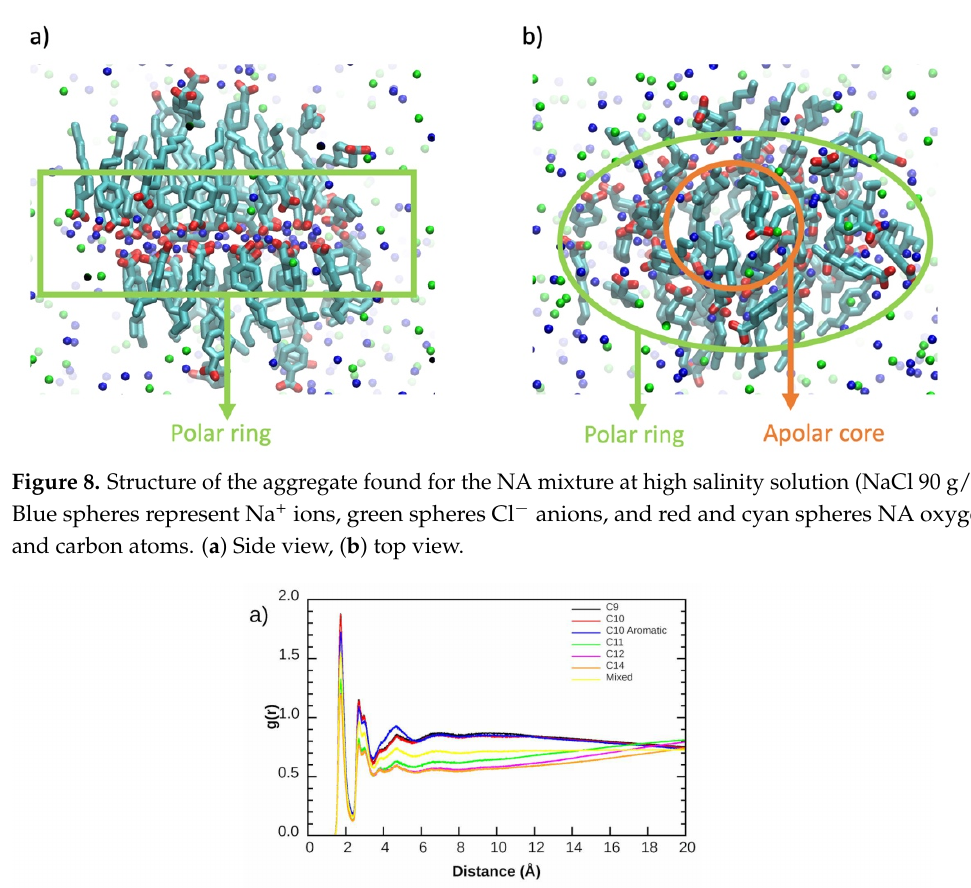
11 of 15 Figure 7. Radial distribution function quantifying the distribution of NAs around each single NA center of mass in ( a ) pure water, ( b ) low salinity solution (NaCl 35 g/L), and ( c ) high salinity solution (NaCl 90 g/L). An interesting result of this analysis is the salinity’s significant role in mediating the aggregates’ formation. A detailed structural analysis of the aggregate morphology and the relative arrangements of NAs indicate that they adopt a structure that, at first sight, resembles a bilayer-like structure, as shown in Figure 8. However, the polar groups adopt a circular arrangement, with the center of the aggregate having an apolar character, as shown in the side view (Figure 8b). Interestingly, this bilayer-like circular arrangement displays the polar groups on the inner part of the aggregate, with a layer of sodium cations placed in the interior and interacting with the NA carboxylic groups. This can be seen in Figure 8, where Na + cations are arranged along the bilayer near the charged oxygens of the acids. Very similar behavior is found for all the systems studied when large aggregates are formed, regardless of the alkyl chain size. In order to shed light on the structure of the water along this arrangement, we show the radial distribution functions quantifying the